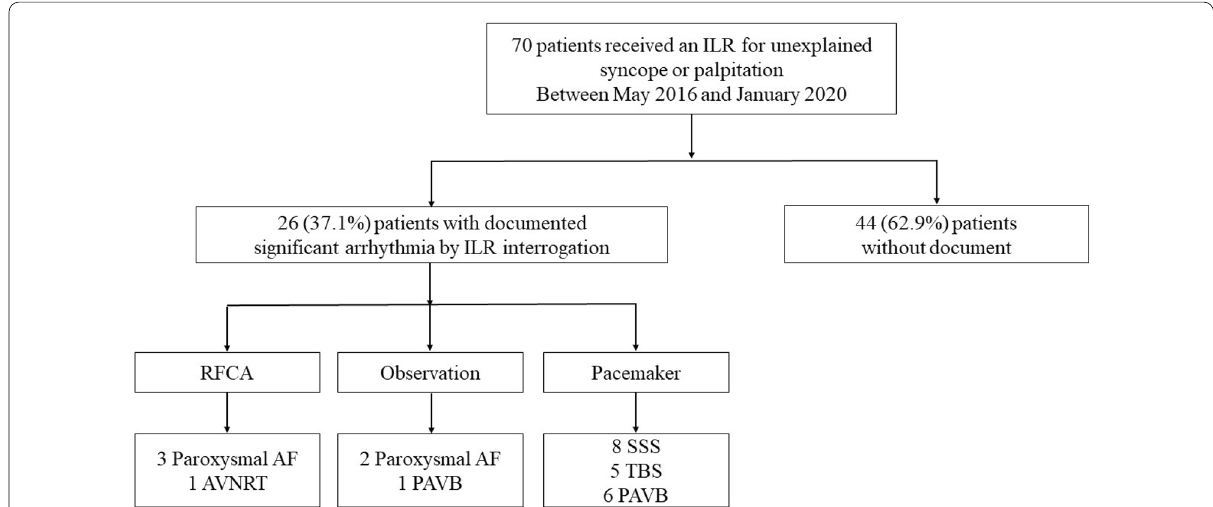
Fig. 1 Study Flow. Flowchart showing the study design and further management of patients who received ILR. ILR, implantable loop recorder; AF, atrial fibrillation; AVNRT, atrioventricular nodal reentry tachycardia; PAVB, paroxysmal atrioventricular block; SSS, sick sinus syndrome; TBS, tachycardia‑bradycardia syndrome; RFCA, radiofrequency catheter